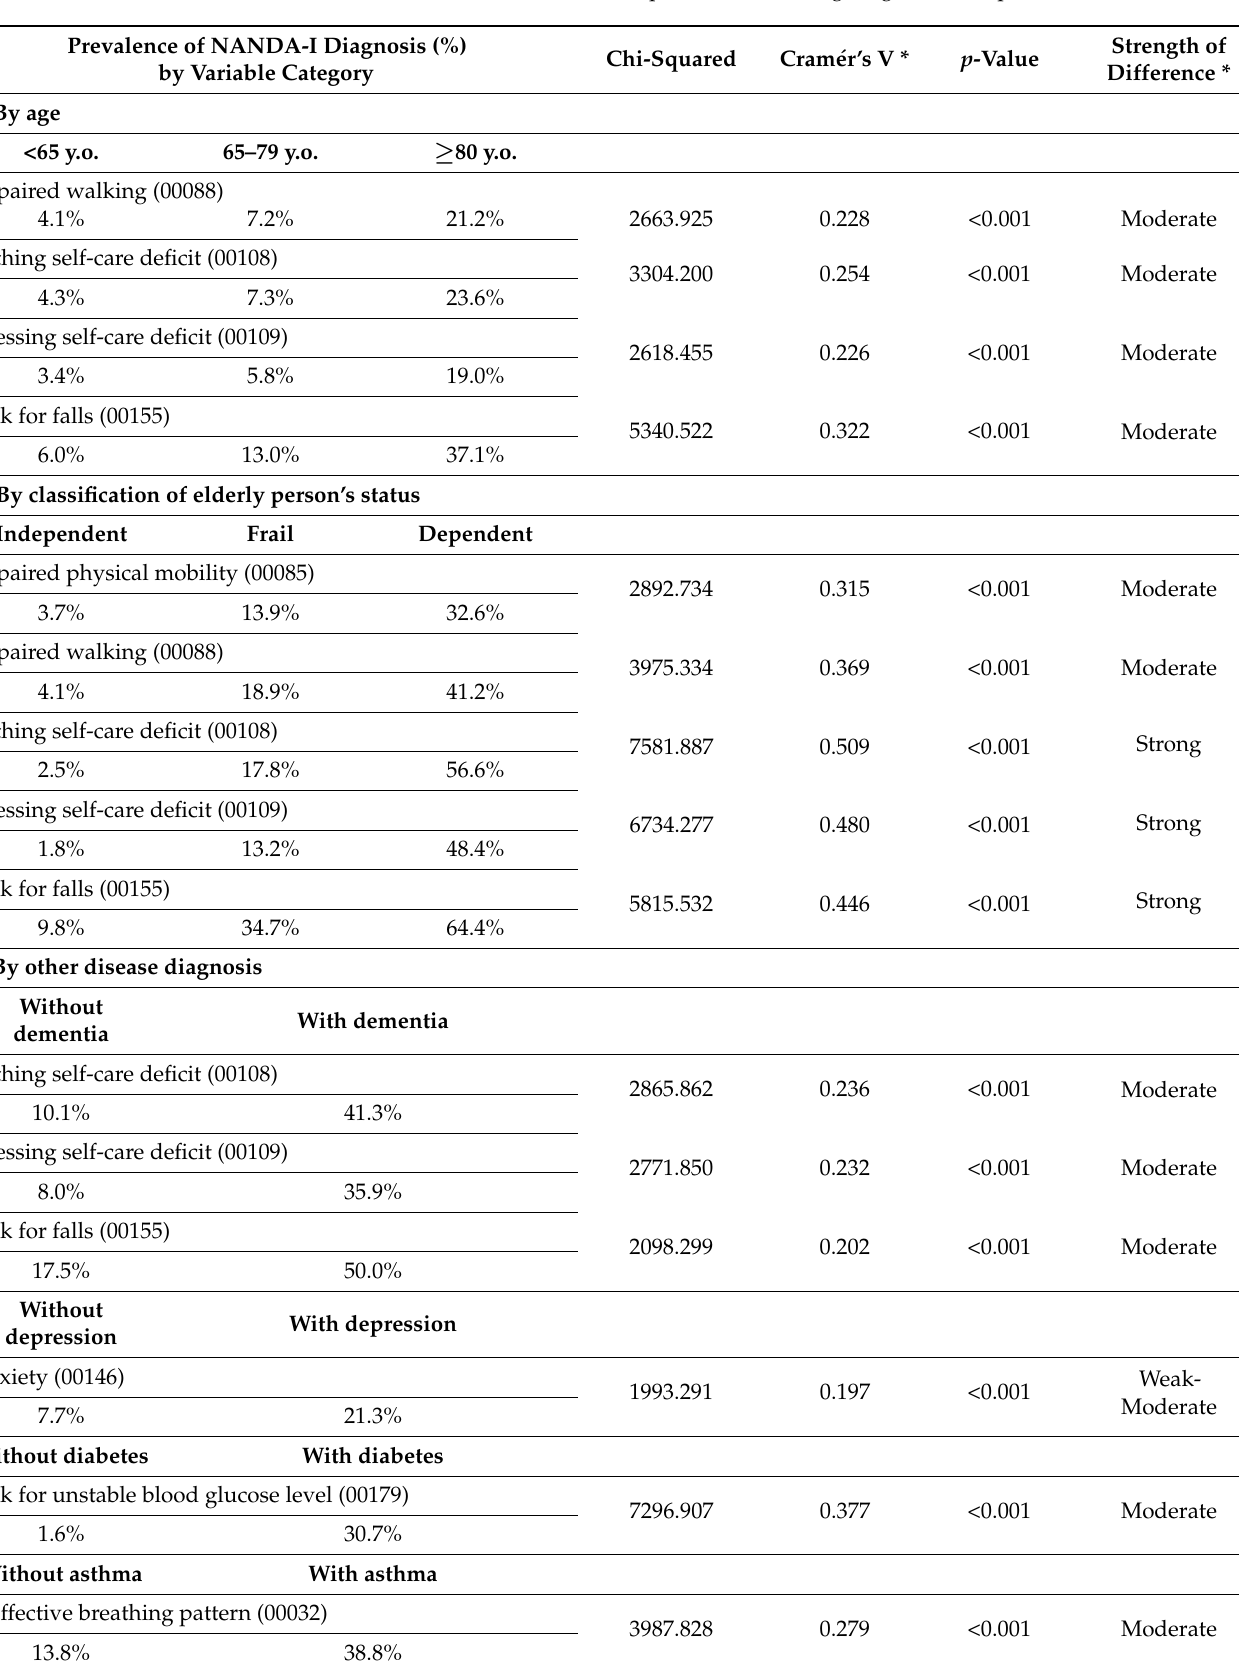
Table 6. Tests of association between presence of nursing diagnoses and patient